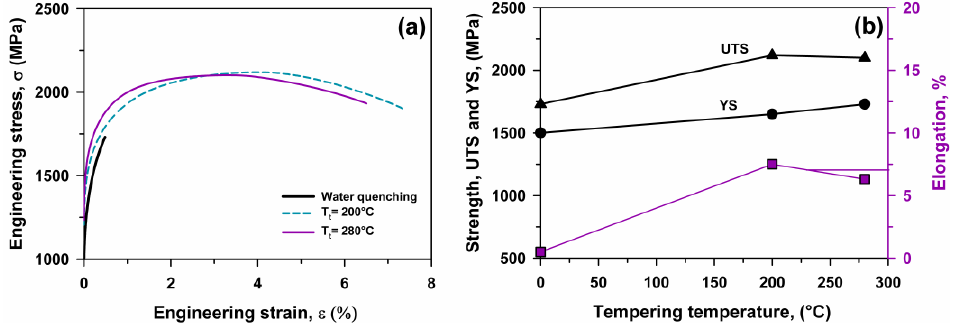
Figure 10. Typical engineering stress–strain curves ( a ), effect of tempering temperature on the ten- sile properties (YS, UTS, elongation) ( b ) of the Fe - 0.44C